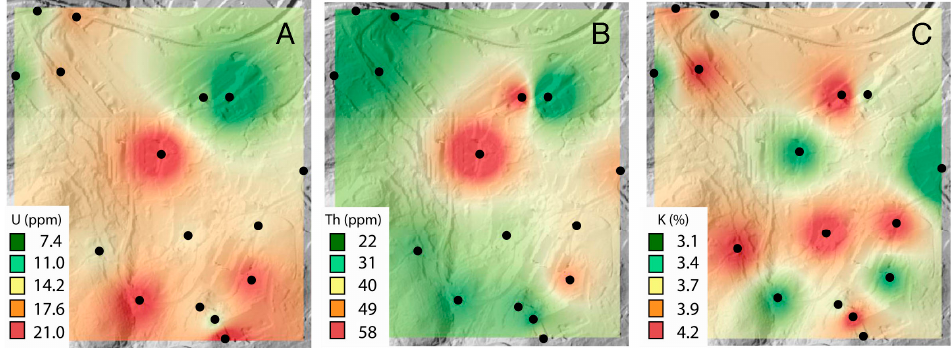
Figure 3. Interpolation map obtained from the GIS with contents of ( A ) U, ( B ) Th, and ( C ) K estimated by geochemical analyses (XRF + ICP-MS).